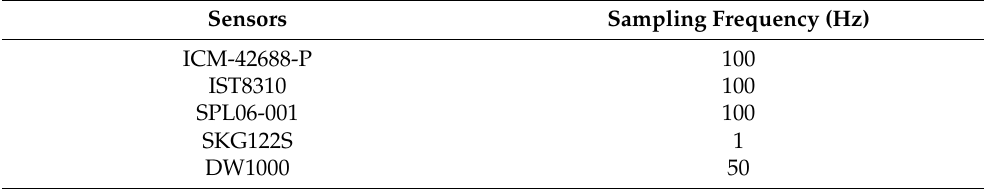
Figure 4. Building environment. Table 1. Sensor configuration parameters.